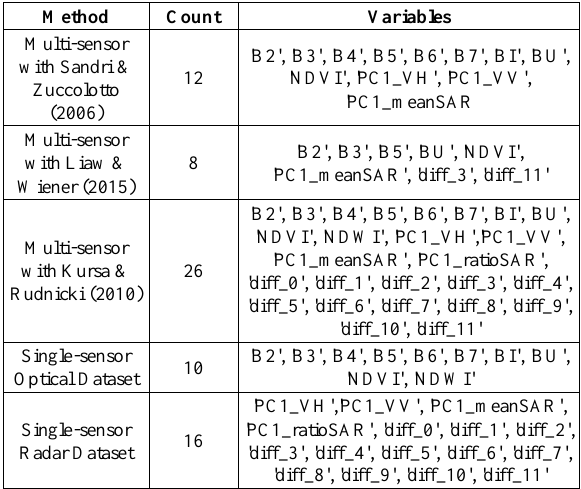
Table 2. List of Variables for each